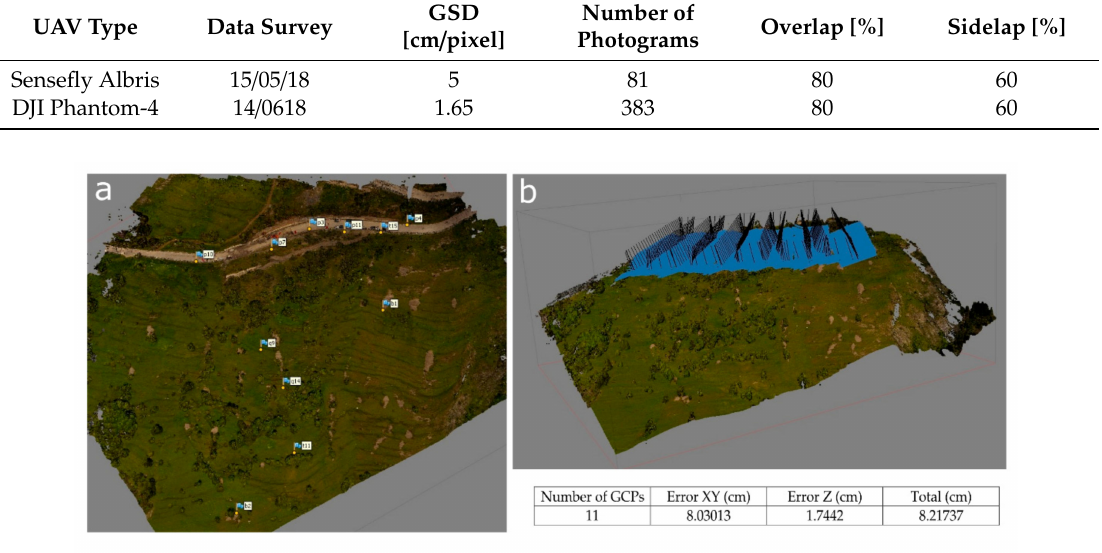
Figure 4. 14 June 2018 UAV flight planning: ( a ) Ground control points (GCPs) distribution, with XY and Z errors associated, and ( b ) camera